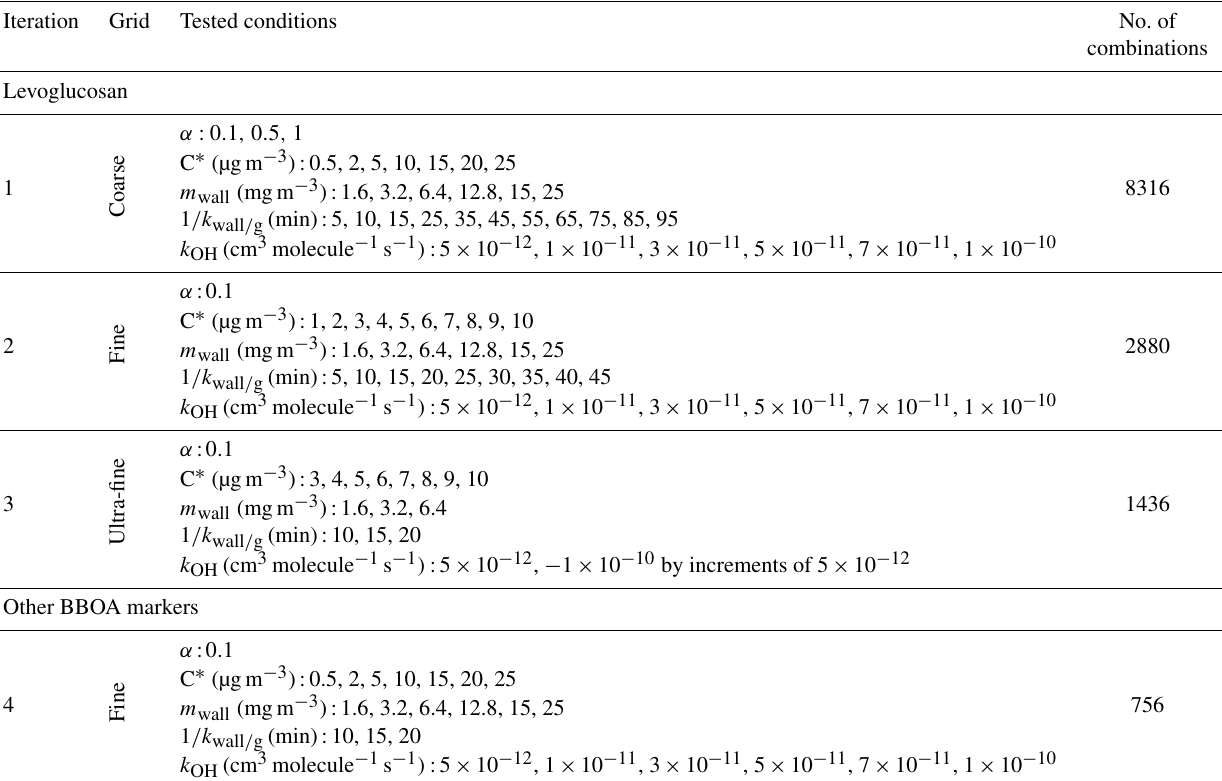
Table 2. Conditions tested for every iteration of the model in the case of levoglucosan as well as other BBOA markers (mannosan, coniferyl aldehyde, acetosyringone, and 3-guaiacyl propanol). Iteration Grid Tested conditions No. of